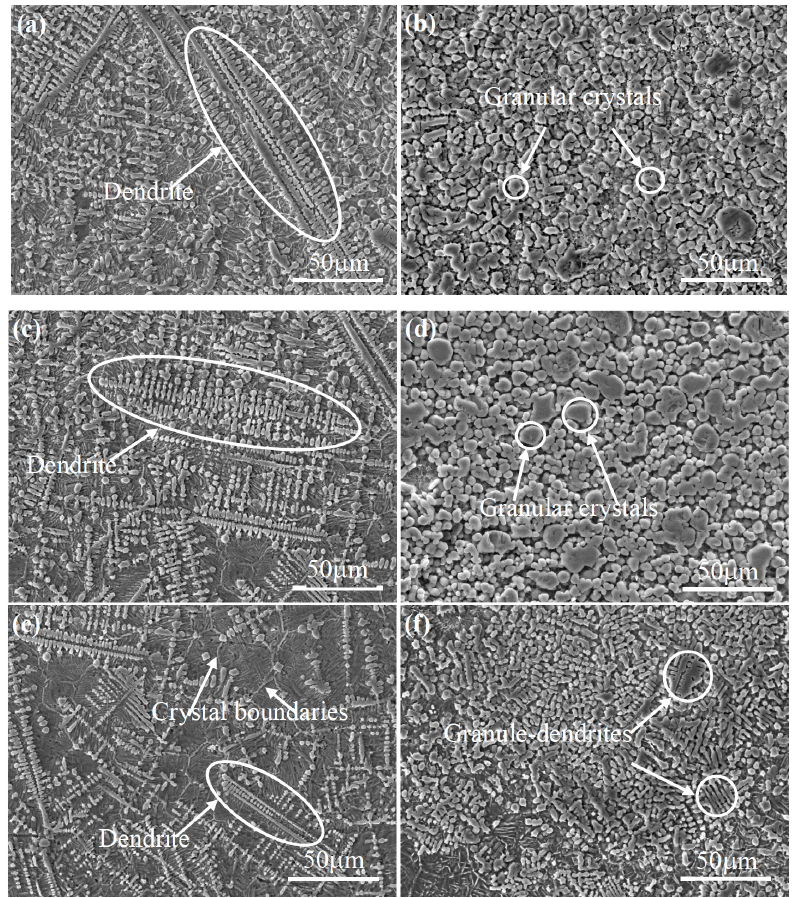
Figure 5. The cross-section microstructure images of the coatings ( a , c , e ) without CeO 2 and ( b , d , f ) modified with CeO 2 : Upper ( a , b ), middle ( c , d ), and bottom ( e , f ) regions of the coatings.